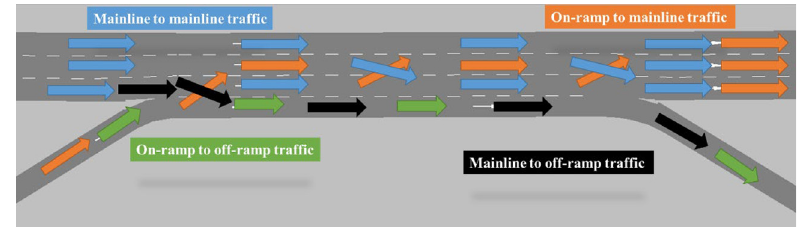
Figure 4 Four-lane lane-changing in weaving area